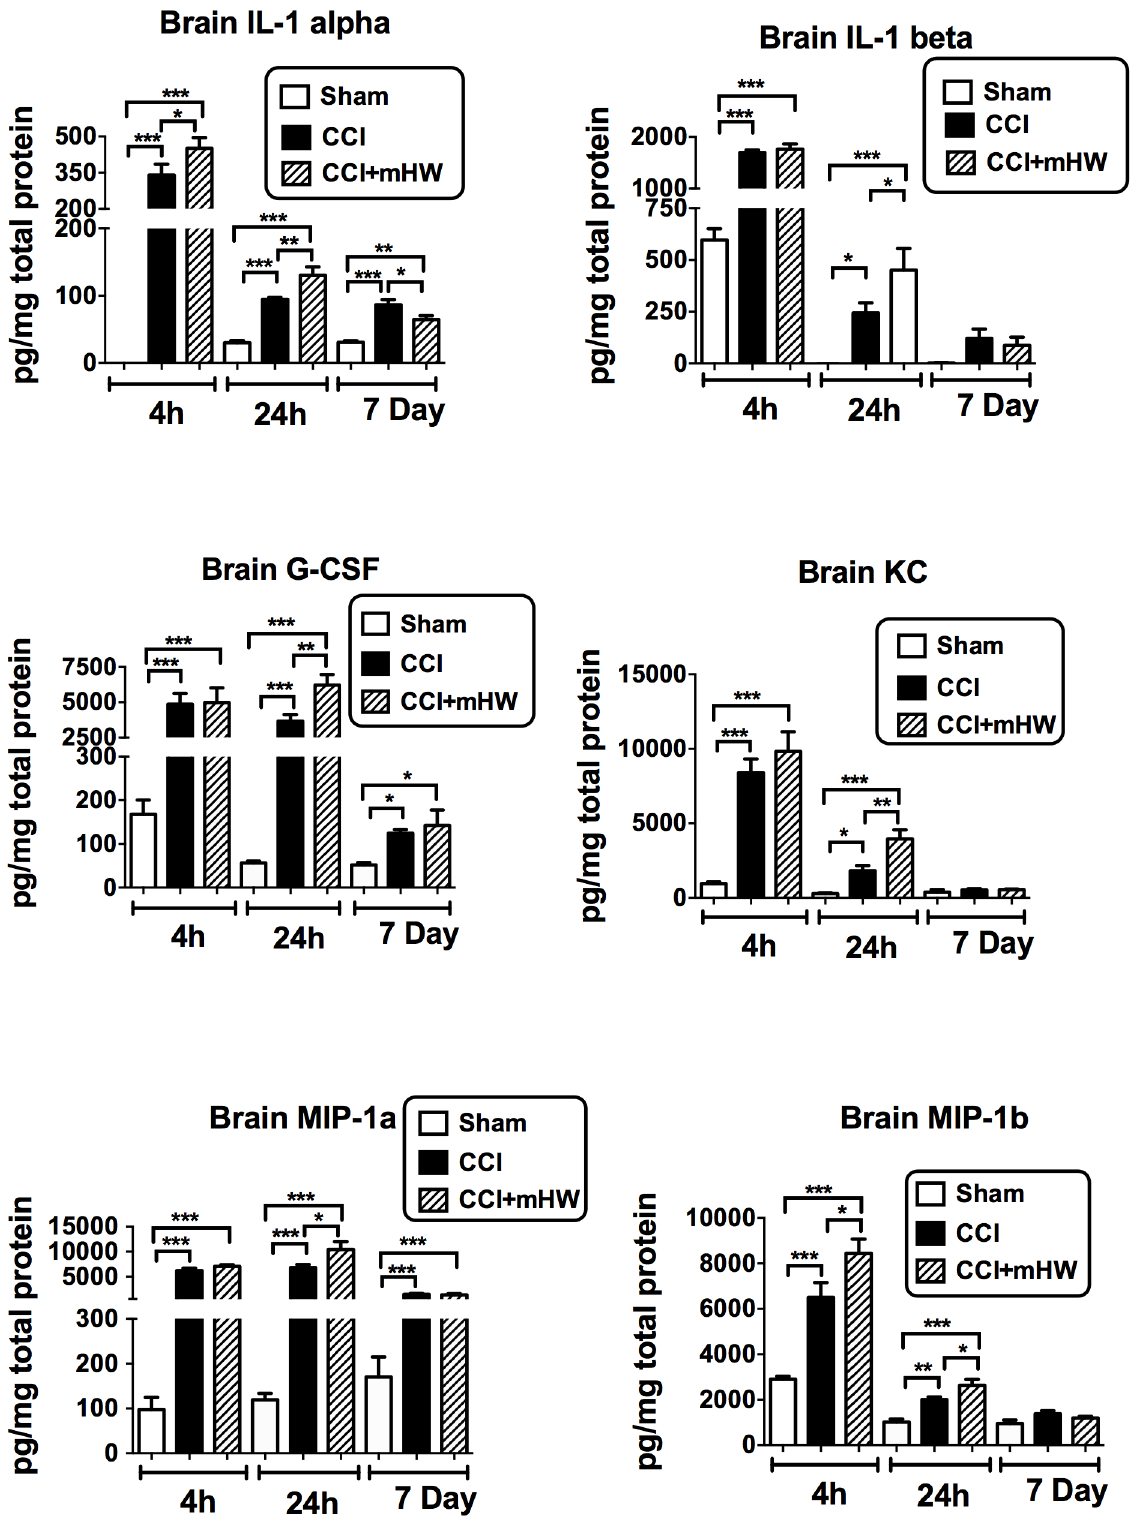
Figure 7. CCI-induced Elevations in Six Cytokines in Brain Were Affected by mHW. IL-6 (not shown; see Table 1 for results) had a pattern similar to G-CSF. Except for the day 7 IL-1 a value, the statistically significant effects of mHW were to further increase brain cytokine levels. *p , 0.05; **p , 0.01; ***p , 0.001.